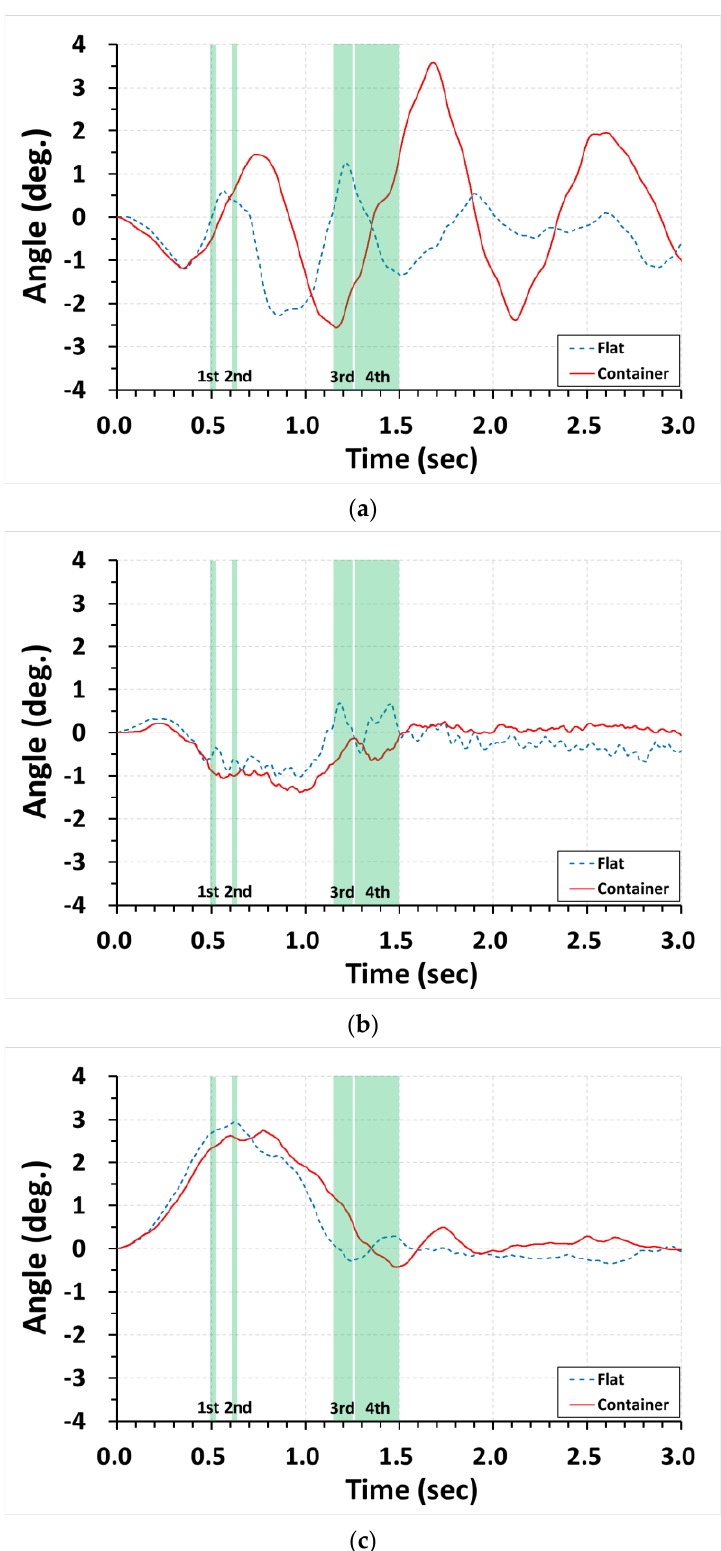
Figure 18. Comparison of vehicle angles after derailment: ( a ) rolling behavior, ( b ) pitching behavior, and ( c ) yawing behavior.